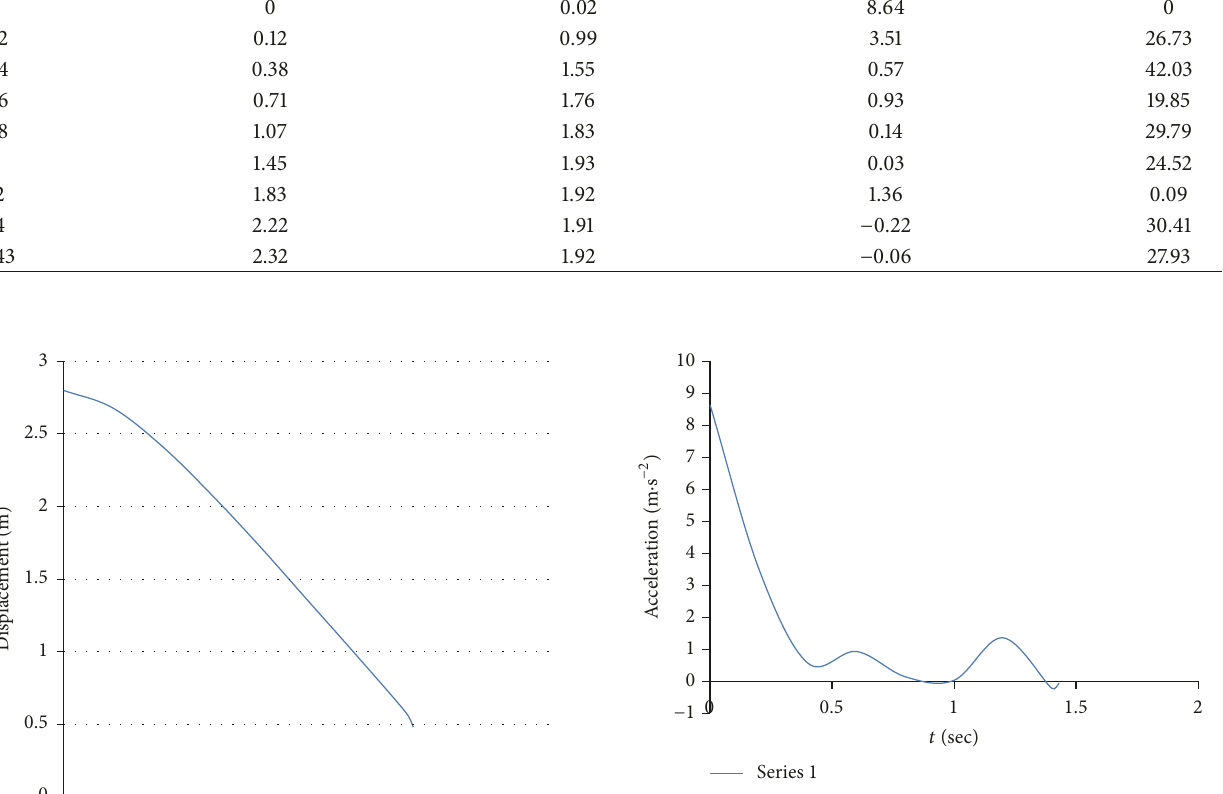
Figure 6: Acceleration time history of the control